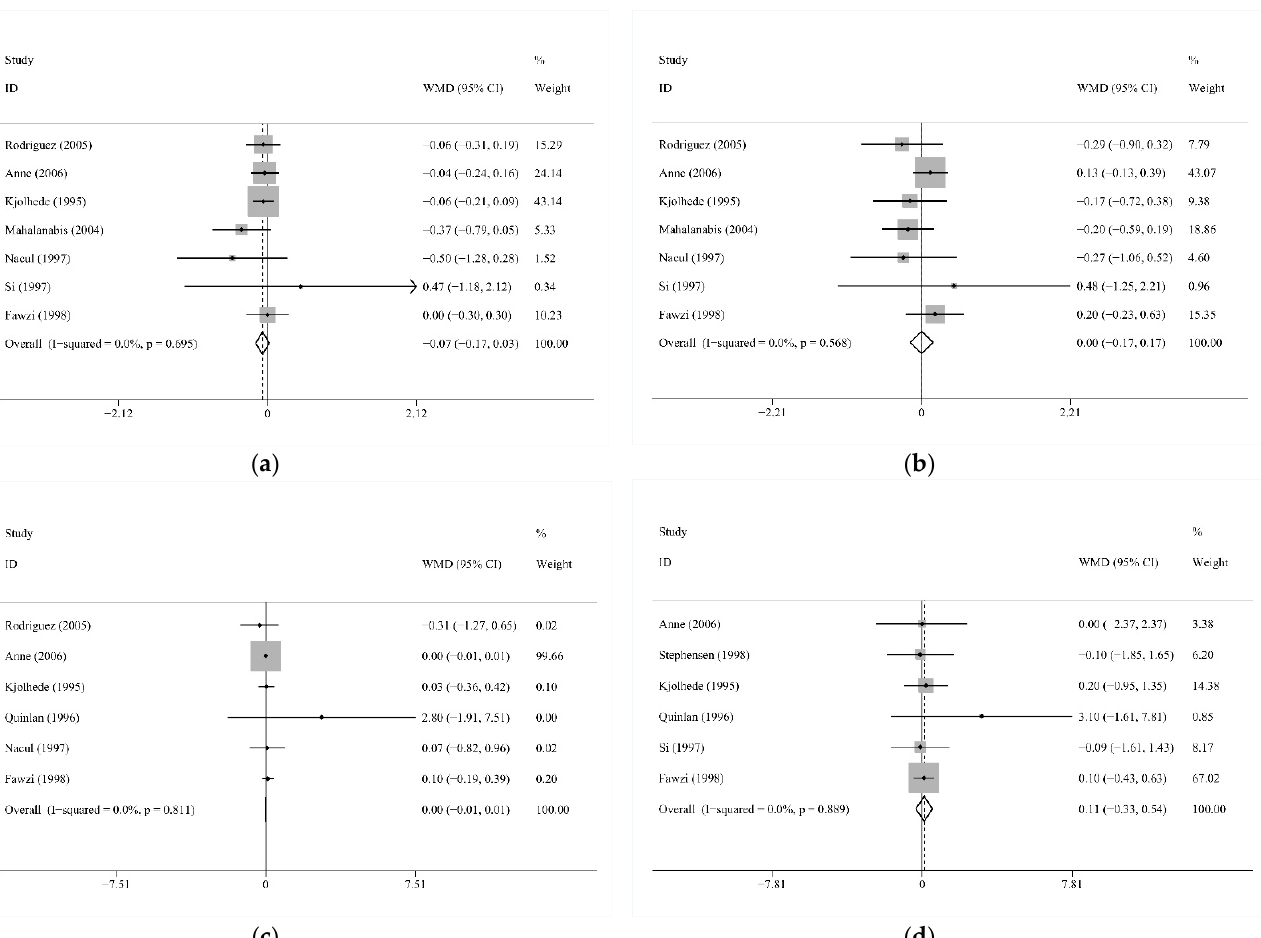
Figure 5. ( a ) Comparison of Vitamin A versus Control, Outcome 7—Days to resolution of fever due to lower respiratory tract infection (LRTI) at longest follow-up; ( b ) Comparison of Vitamin A versus Control, Outcome 8—Days for respiratory rate to settle due to lower respiratory tract infection (LRTI) at longest follow-up; ( c ) Comparison of Vitamin A versus Control, Outcome 9—Days to normalization of SpO2 due to lower respiratory tract infection (LRTI) at longest follow-up; ( d ) Comparison of Vitamin A versus Control, Outcome 10—Days in hospital due to lower respiratory tract infection (LRTI) at longest follow-up; WMD: weighted mean difference.